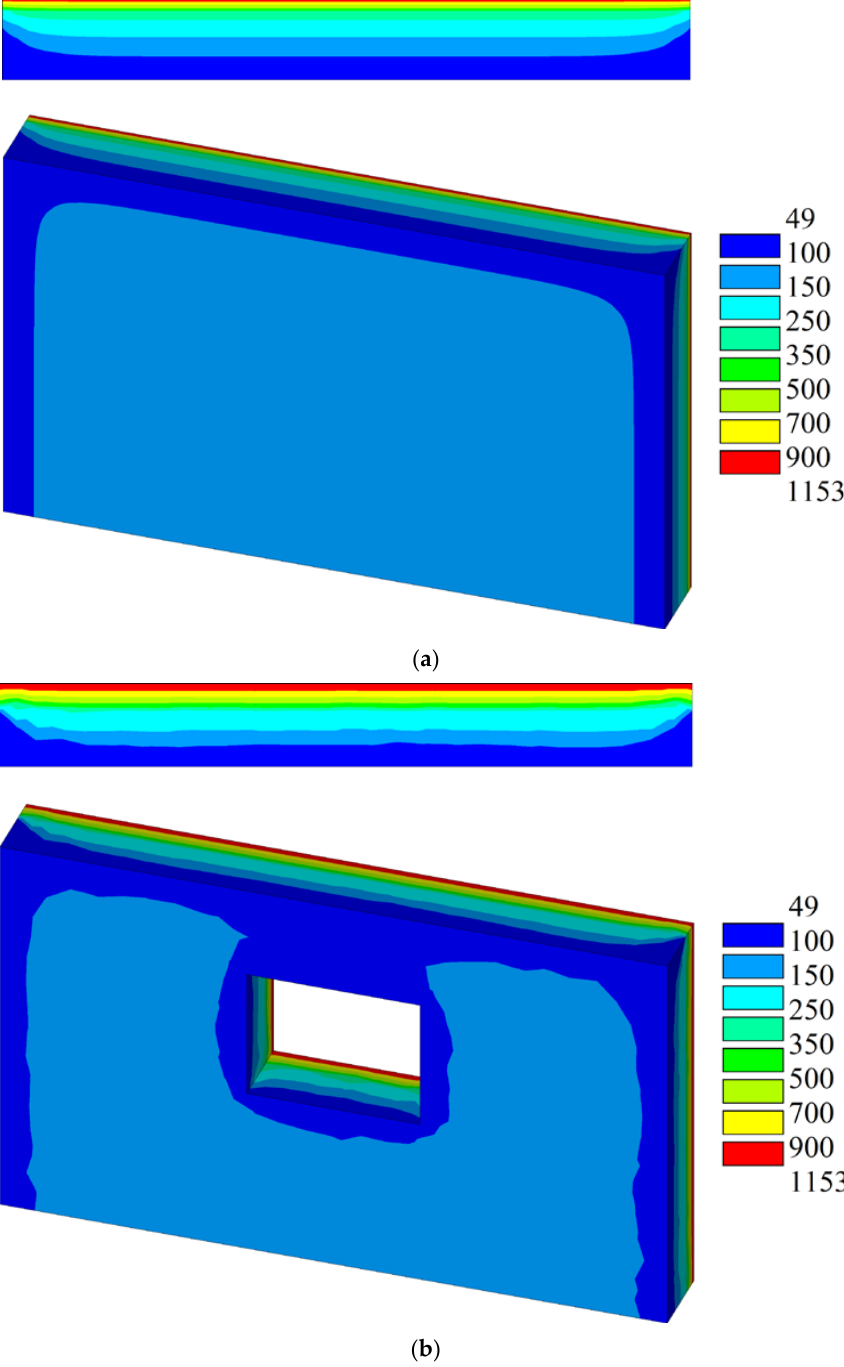
Figure 15. Analysis results for ( a ) W2A and ( b ) W2B specimens (material thermal conductivity 1 W / m